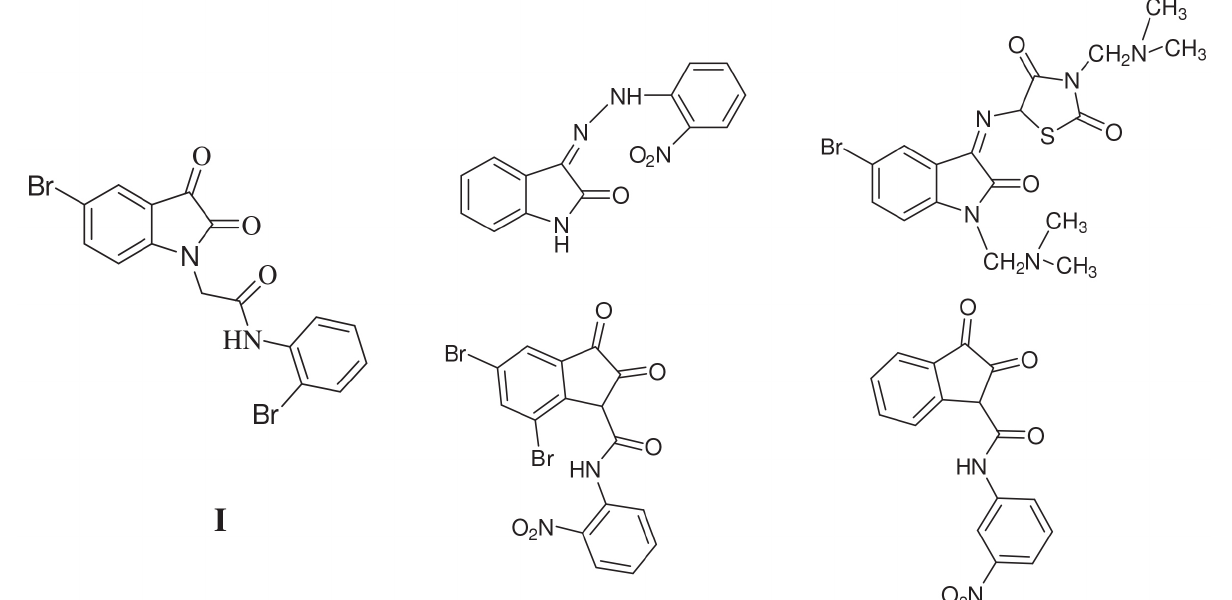
FIGURE 1 - Structures of isatin derivatives reported to be CDC25B and PTP1B inhibitors and I